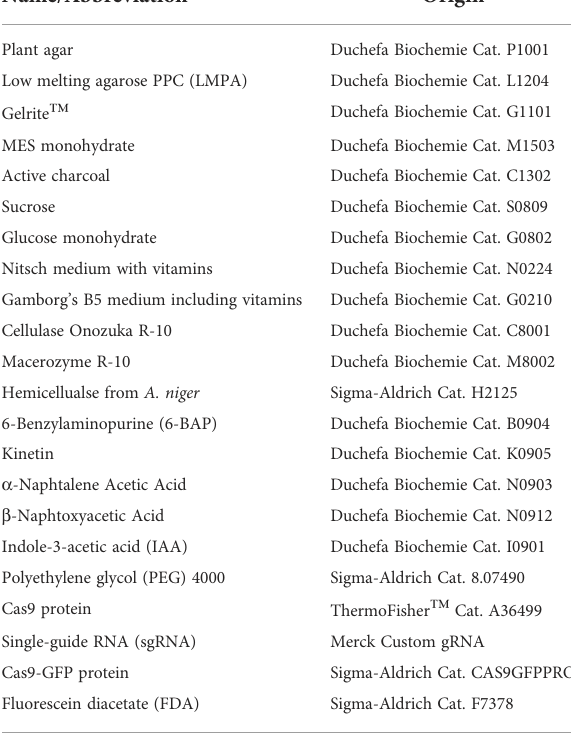
TABLE 2 List of reagents required to perform protoplast isolation, transfection, and